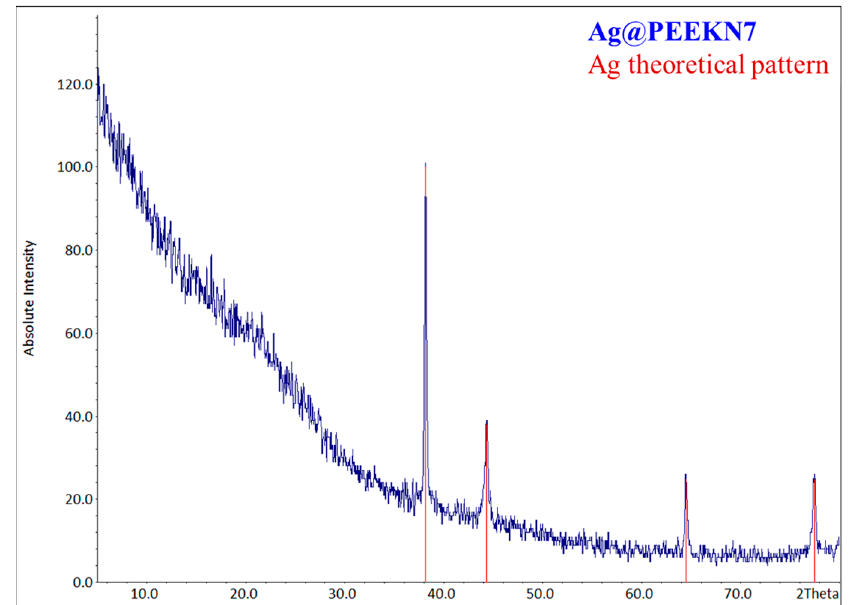
Figure 13. X-ray powder diffractogram of the precipitate of silver nitrate with PEEKN7 after TGA analysis (blue) and theoretical silver pattern (red).